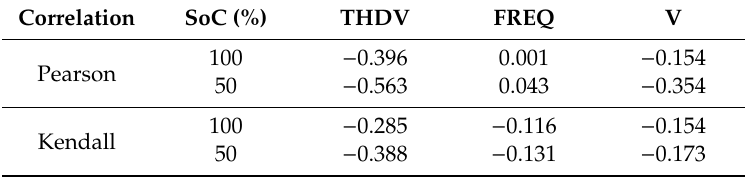
Table 5. Correlations coefficients between PQ parameters and load parameter.